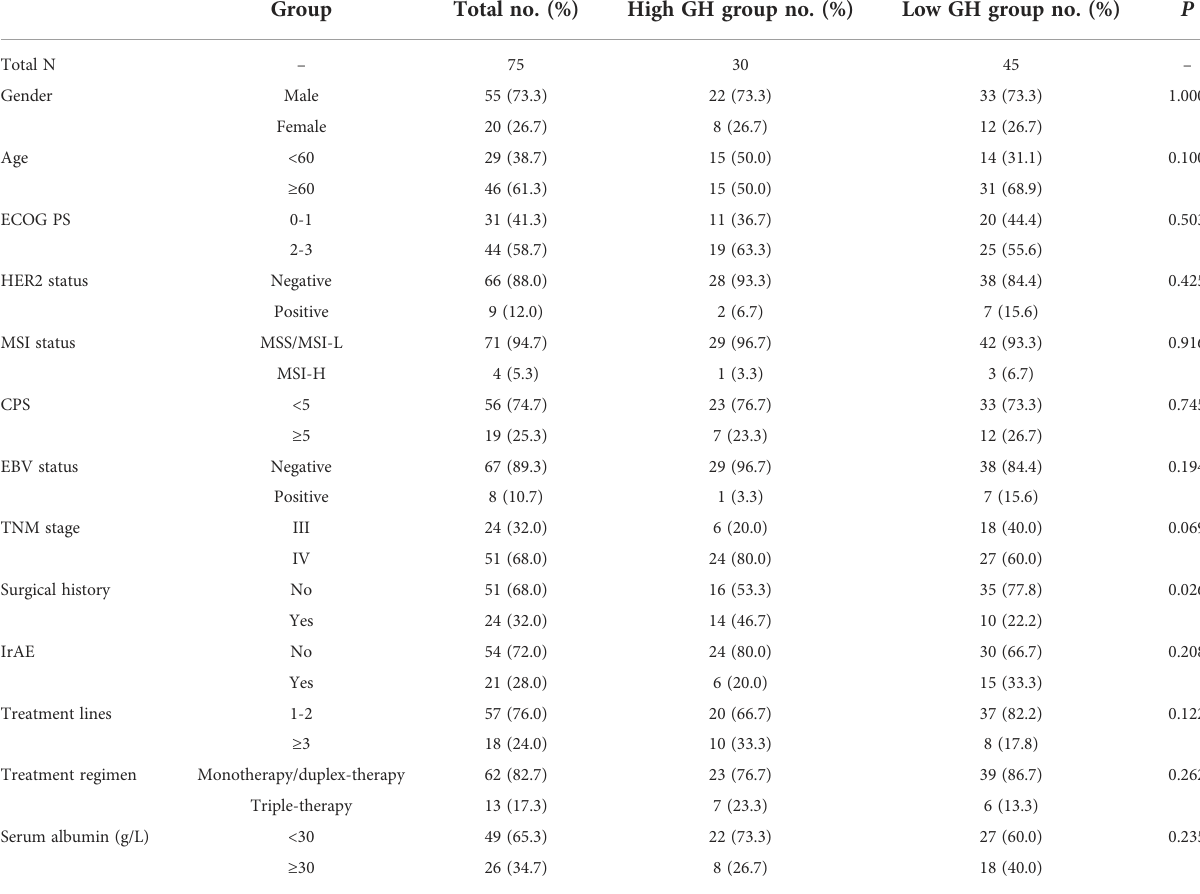
TABLE 1 Characteristics of AGC patients with different posttreatment GH levels. Group Total no. (%) High GH group no.